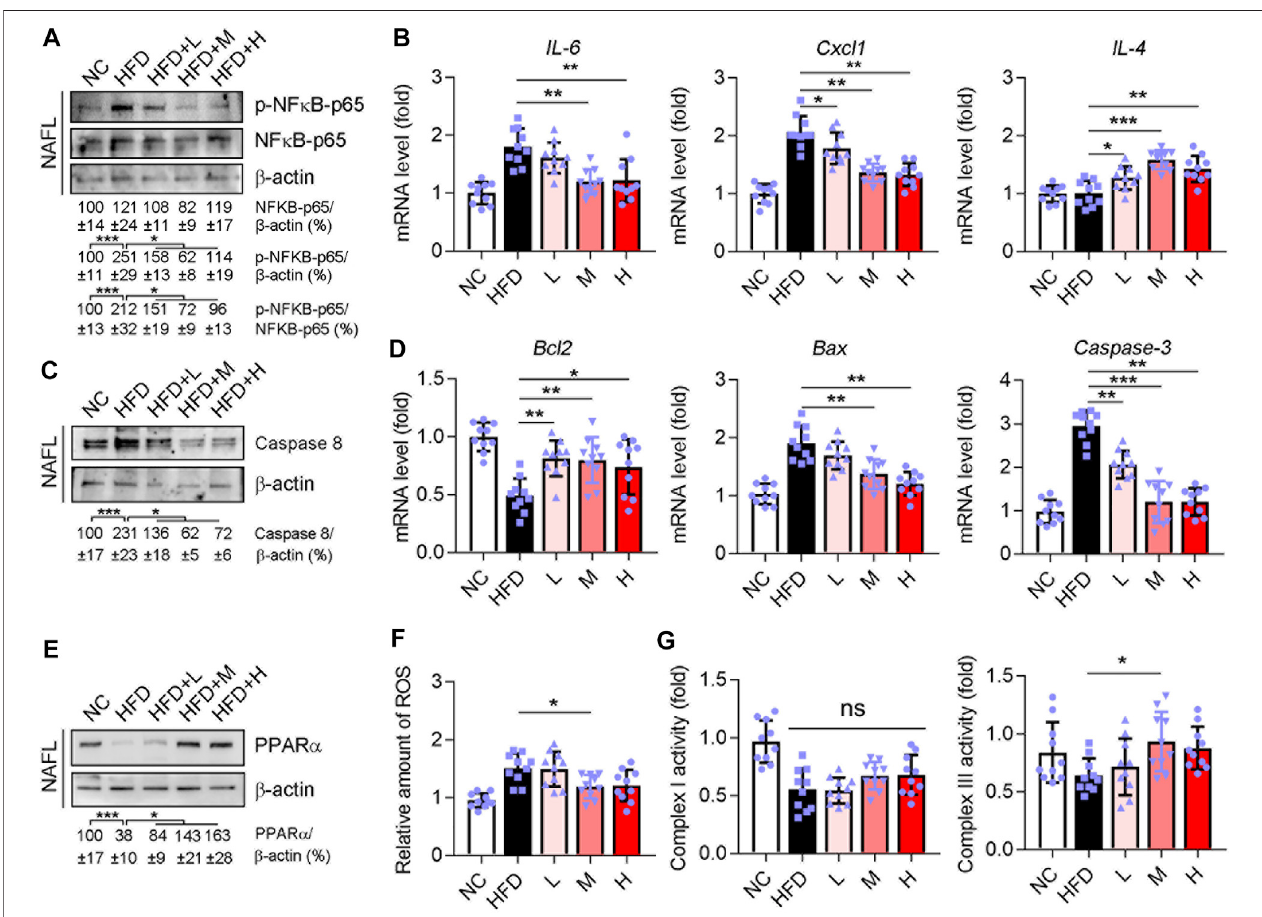
FIGURE7| Ganweikangtabletreducesin fl ammation,apoptosis,andfattyacidoxidationintheliverofNAFLmice.C57BL/6J-backgroundmiceinducedintoNAFL model by HFD, n = 3. (A) Western blotting demonstrates the expression of p-NF κ B-p65 and NF κ B-p65, n = 3. (B) Differences in mRNA fold level changes of IL6 , Cxcl1, and IL4 betweentheindicatedgroups( n =10miceexaminedpergroup). (C) WesternblottingdemonstratestheexpressionofCaspase8, n =3. (D) DifferencesinmRNA foldlevelchangesof Bcl2 , Bax, and Caspase3 betweentheindicatedgroups( n =10miceexaminedpergroup). (E) Westernblottingdemonstratestheexpression ofPPAR α , n =3. (F) DifferencesintheamountofROSbetweentheindicatedgroups( n =10miceexaminedpergroup). (G) Differencesinactivitybetweenthegroupsfor complex I and complex III ( n = 10 mice examined per group). * p < 0.05, ** p < 0.01, *** p < 0.001, by one-way ANOVA with Bonferroni correction. ns, no signi fi cance.